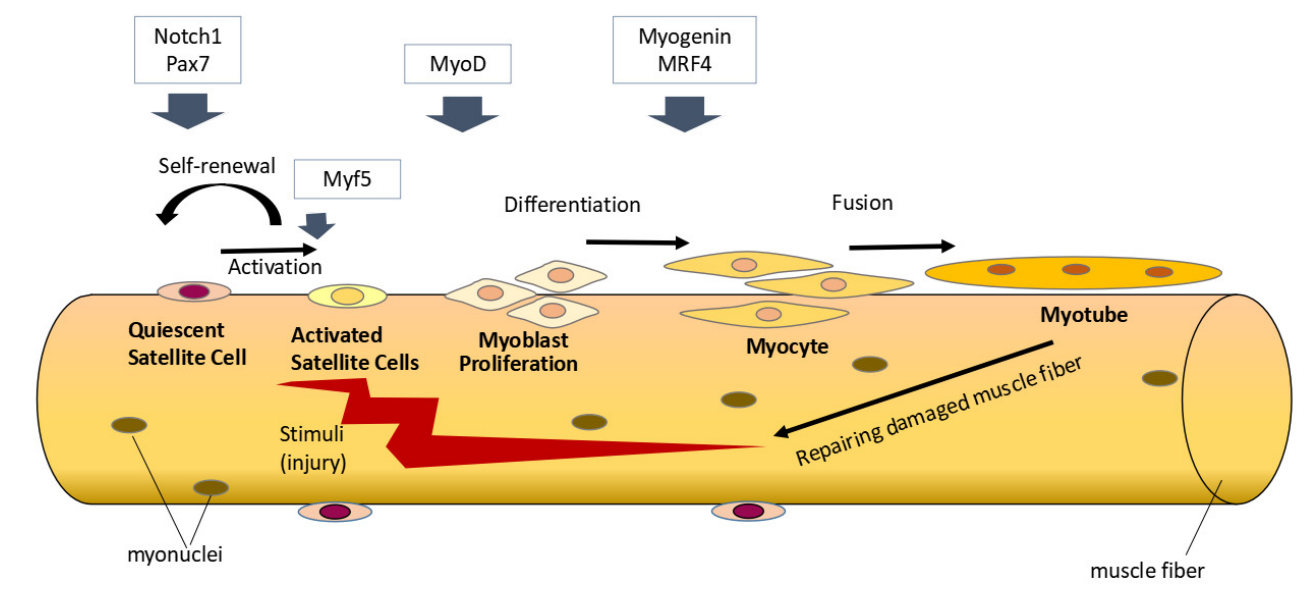
Figure 1. Satellite cells’ activity in skeletal muscle regeneration. Under homeostatic conditions, sat- ellite cells are typically in a quiescent state and express Pax7. Notch signaling plays a role in main- taining the quiescent state of satellite cells. When there are stimuli for skeletal muscle regeneration, various myogenic regulatory factors (Myf5, MyoD, myogenin, and MRF4) regulate satellite cells' activation, proliferation, and differentiation to form new muscle fibers. Some satellite cells will un- dergo self-renewal and return to a quiescent state to replenish the satellite cell population. Notch signaling through its regulation of Pax7 plays a role in promoting satellite cell